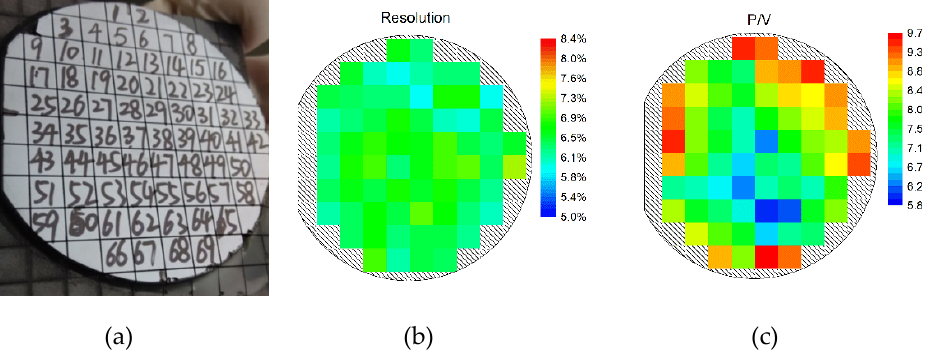
Figure 6. Detector properties under irradiation of 241 Am@59.5 keV; ( a ) numbered detectors on a wafer, ( b ) energy resolution, and ( c ) peak-to-valley ratio.